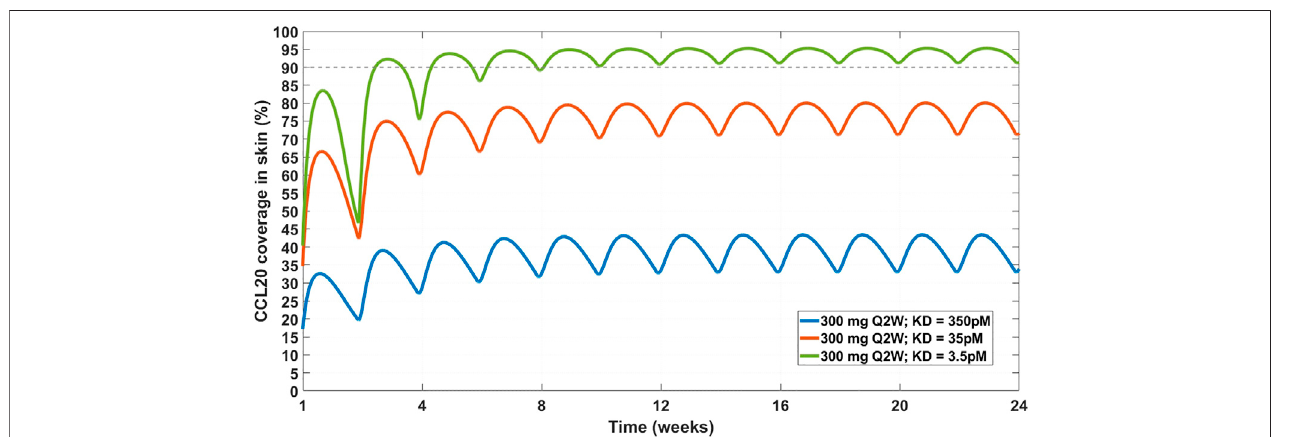
FIGURE7 | Projected CCL20coverage in the skin at 300 mgSC Q2W dosing regimen and varyingaf fi nity. Three af fi nity scenarioswere simulated – 350 pM (solid blue line), 35 pM (solid orange line), and 3.5 pM (solid green line). Thin dashed grey line indicates 90% coverage, which is emphasized for convenience. The model projects that a 3.5 pM af fi nity is required for achieving 90% CCL20 coverage in the